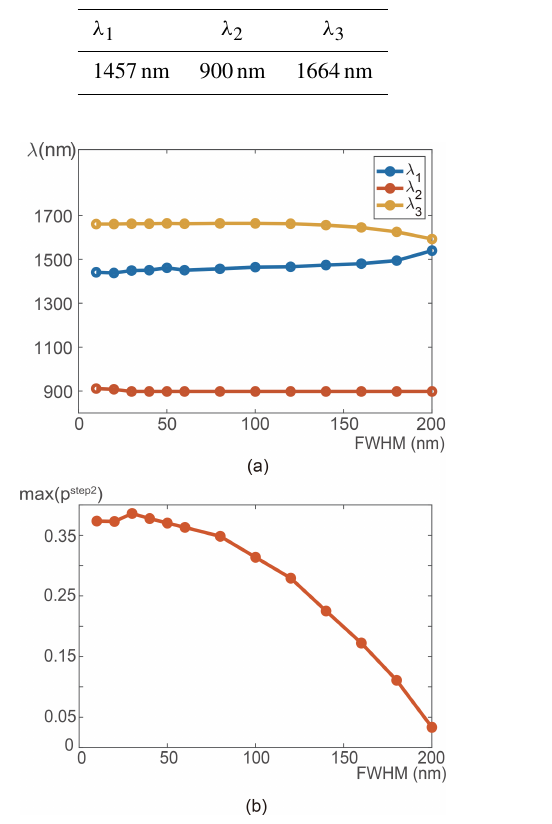
Figure 9. (a) Calculated wavelengths as a function of FWHM. (b) Maximum value of p step2 as a function of